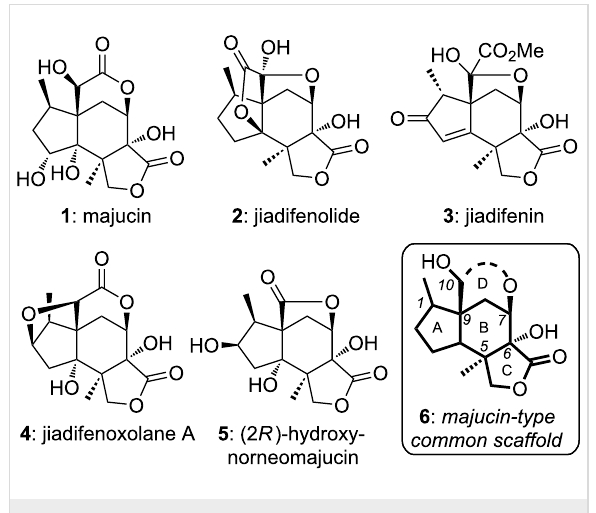
Figure 1: Representative majucin-type Illicium sesquiterpenes.